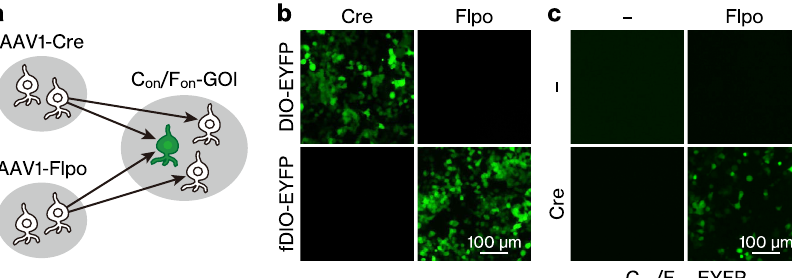
Fig. 1 Outline of the intersectional, anterograde transsynaptic targeting system. a Schematic of the intersectional, anterograde transsynaptic targeting of neurons that receive monosynaptic inputs from two upstream brain regions. b EYFP fl uorescence in 293T cells transfected with recombinase (pAAV-hSyn- Cre or pAAV-hSyn-Flpo-3×FLAG) and recombinase-dependent (pAAV-EF1 α -DIO-EYFP or pAAV-EF1 α -fDIO-EYFP) plasmid combinations. c EYFP fl uorescence in 293T cells transfected with Cre, Flpo, and C on /F on plasmid combinations. The pAAV-hSyn-C on /F on -EYFP plasmid was transfected into all wells. AAV1 adeno-associated virus serotype 1, GOI gene of interest, EYFP enhanced yellow fl uorescent